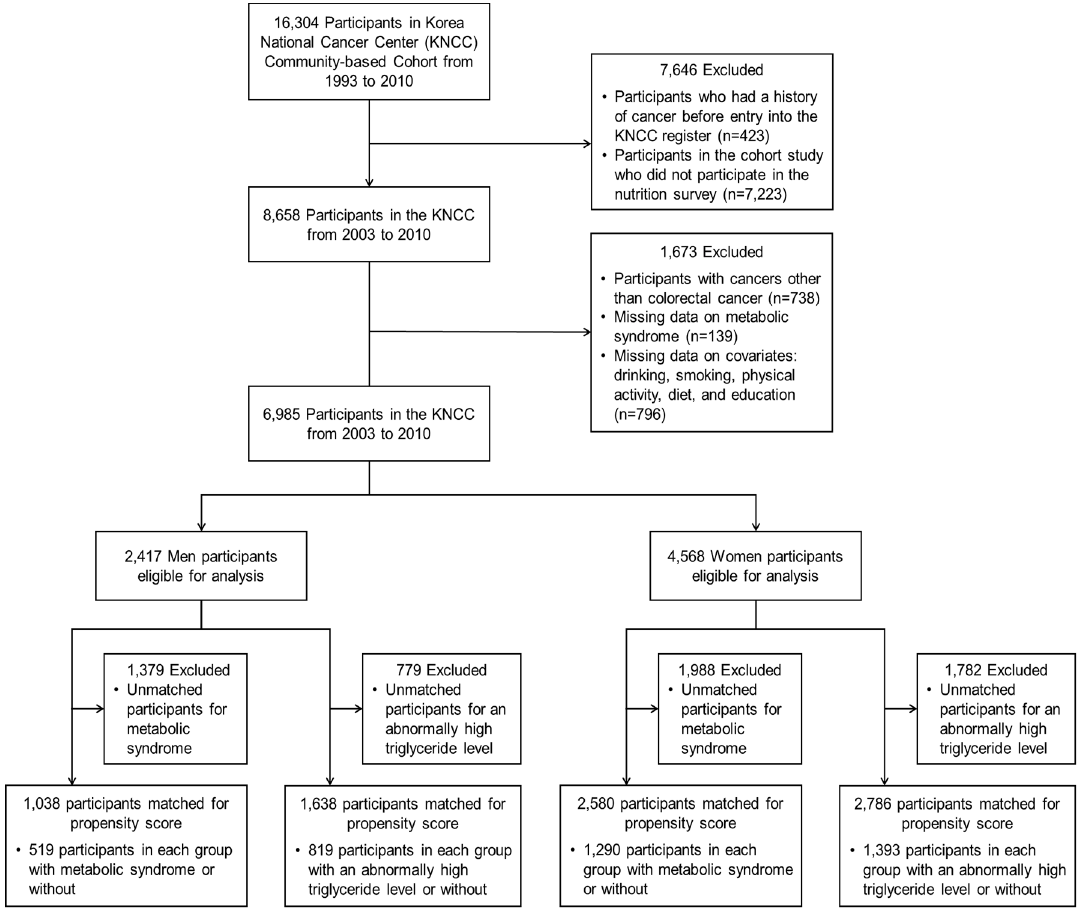
Figure 1. Flow diagram of the derivation of the study population.